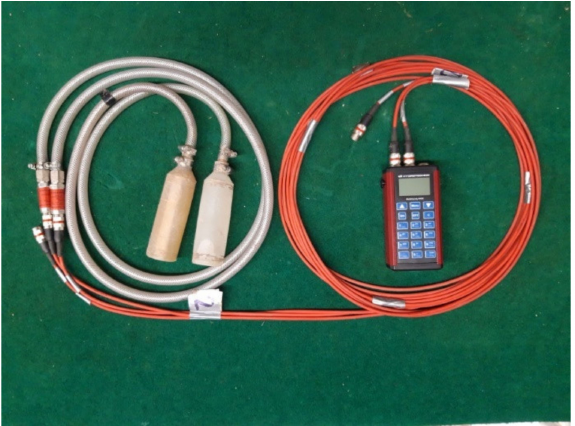
Figure 3. Measuring device for the determination of actual pressures in the soil profile during machine